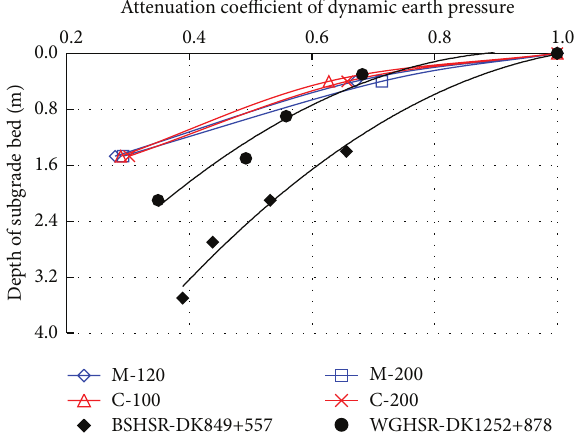
Figure 18: Cumulative settlement of subgrade in different stages.